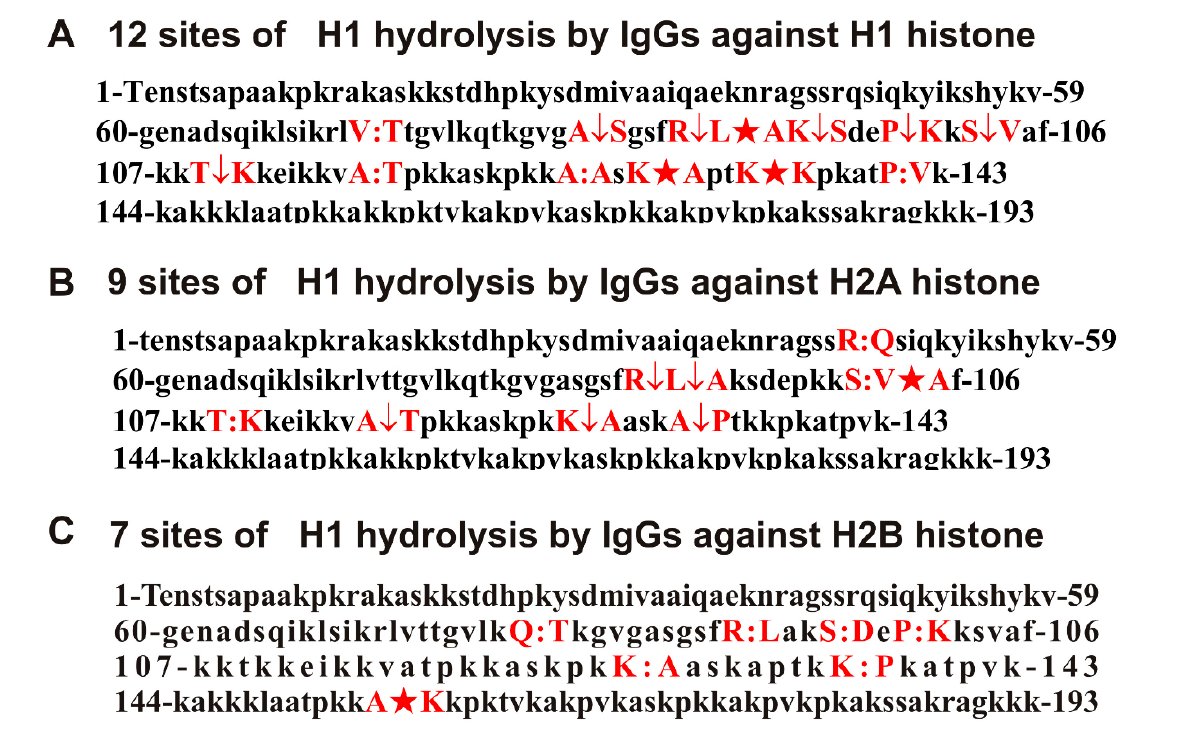
Figure 3. MALDI spectra ( A – G ) corresponding to H1 histone (0.7 mg/mL) hydrolysis over time (6–